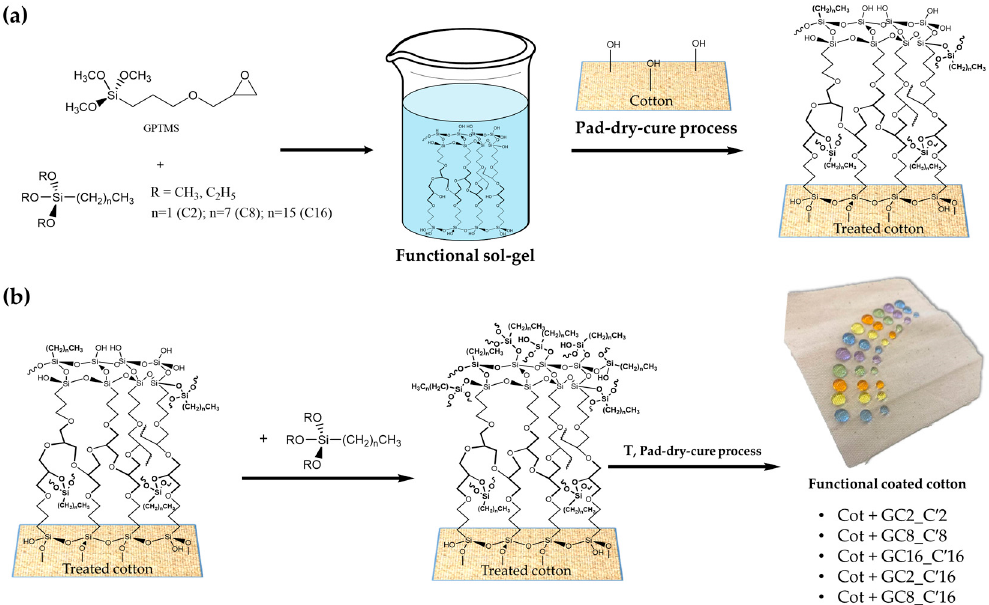
Figure 15. The condensation process between the cellulose and alkoxysilane ends ( a ), followed by the anchoring of alkyl(trialkoxy)silanes ( b ). Reproduced from MDPI Ref. [67].